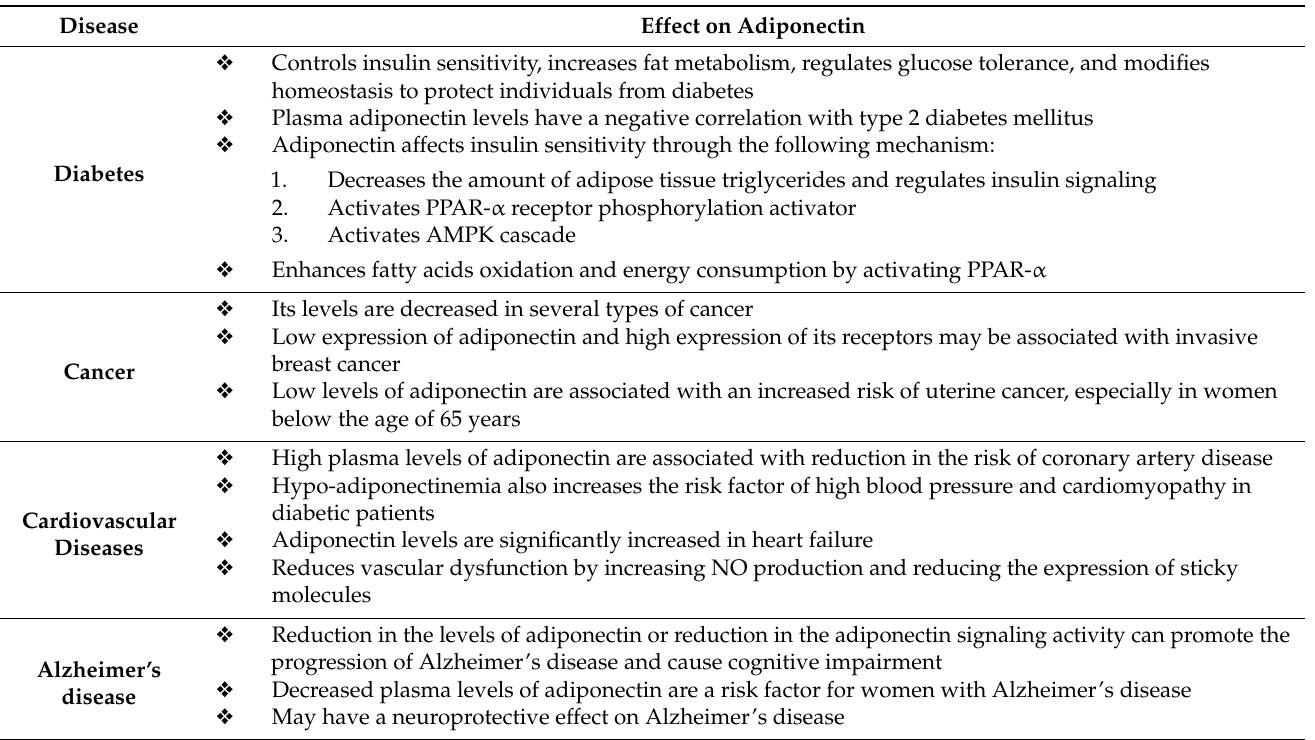
Table 3. Adiponectin and human diseases. Effect on